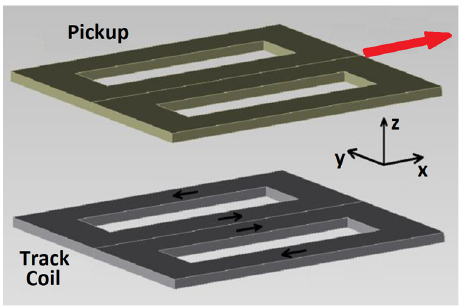
Figure 2. Double D (DD) coupling set.